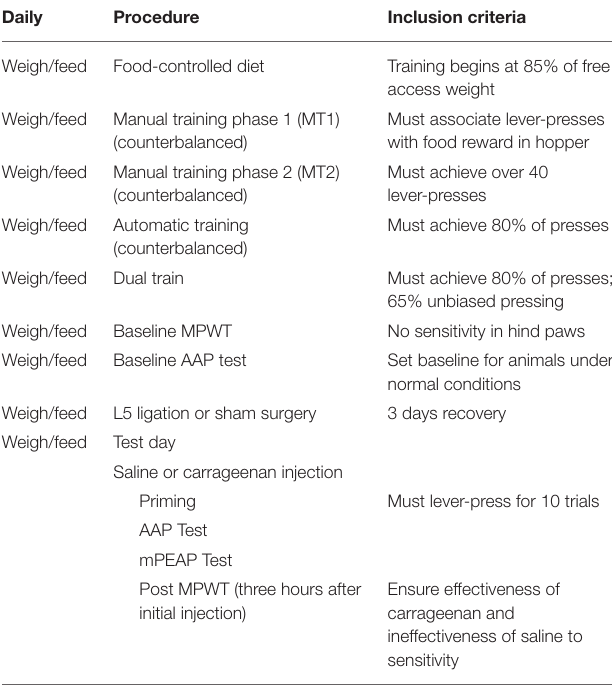
TABLE 1 | Criteria and procedure for approach-avoidance paradigm